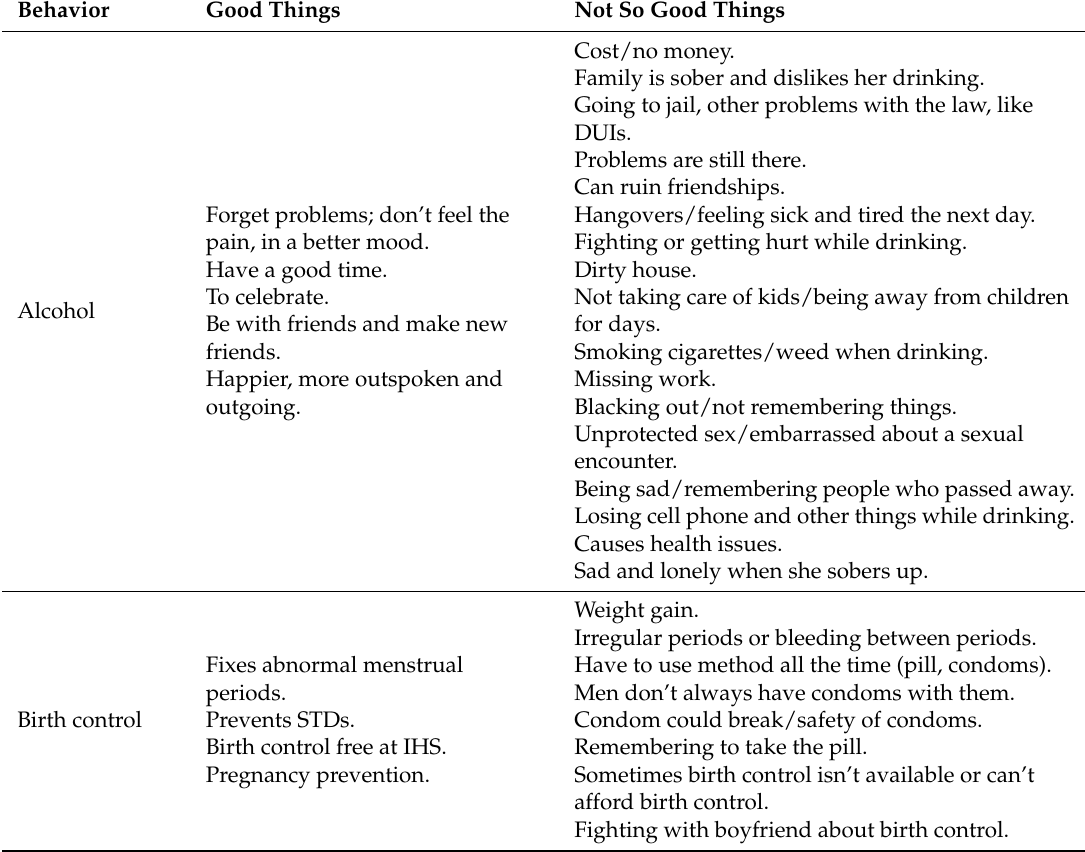
Table 2. Decisional balance exercise responses.